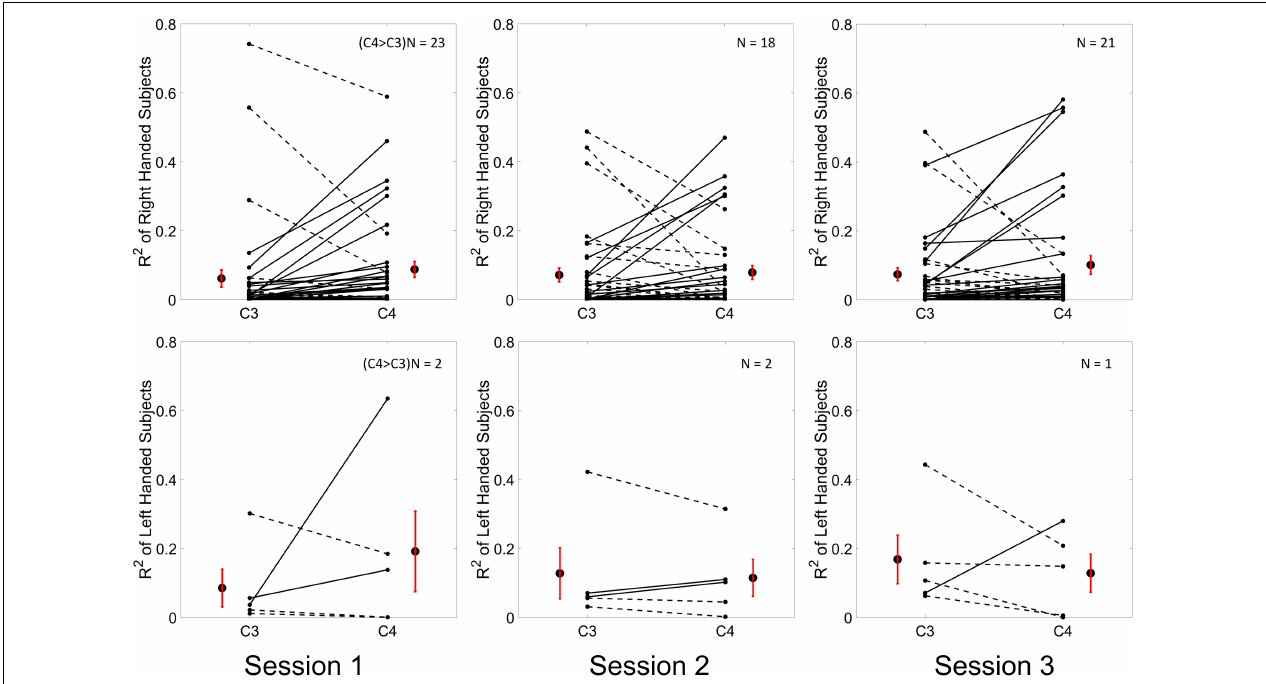
FIGURE 5 | Individual and group average R 2 values of channel C3 and C4 which are calculated from all of the trials across the three training sessions are shown in the first row for N = 37 right handed subjects and in the second row for N = 5 left handed subjects. The R 2 values for each individual and each channel were plotted as a dot in each subplot. A solid line between the value of channel C3 and channel C4 of each individual was depicted if the value of channel C3 was smaller than the value of channel C4, otherwise, a dashed line was connected. The group average R 2 values ± SEM for channel C3 and C4 were shown alongside of the individual R 2 values. The results for three sessions were plotted in three columns,